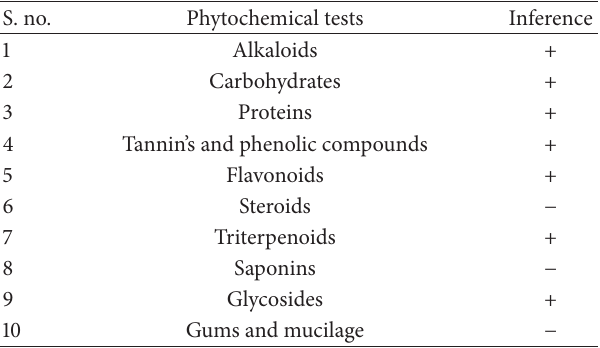
Table 1: Preliminary phytochemical screening of hydroalcoholic extract of Desmostachya bipinnata